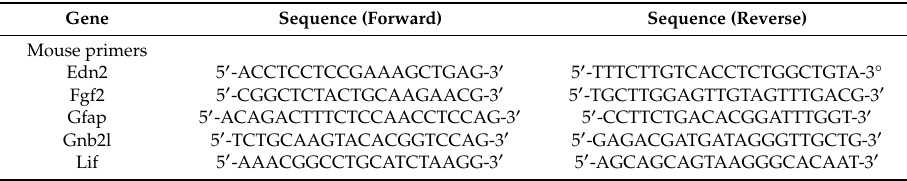
Table 1. Primers used for real-time reverse transcription-polymerase chain reaction (RT-PCR)